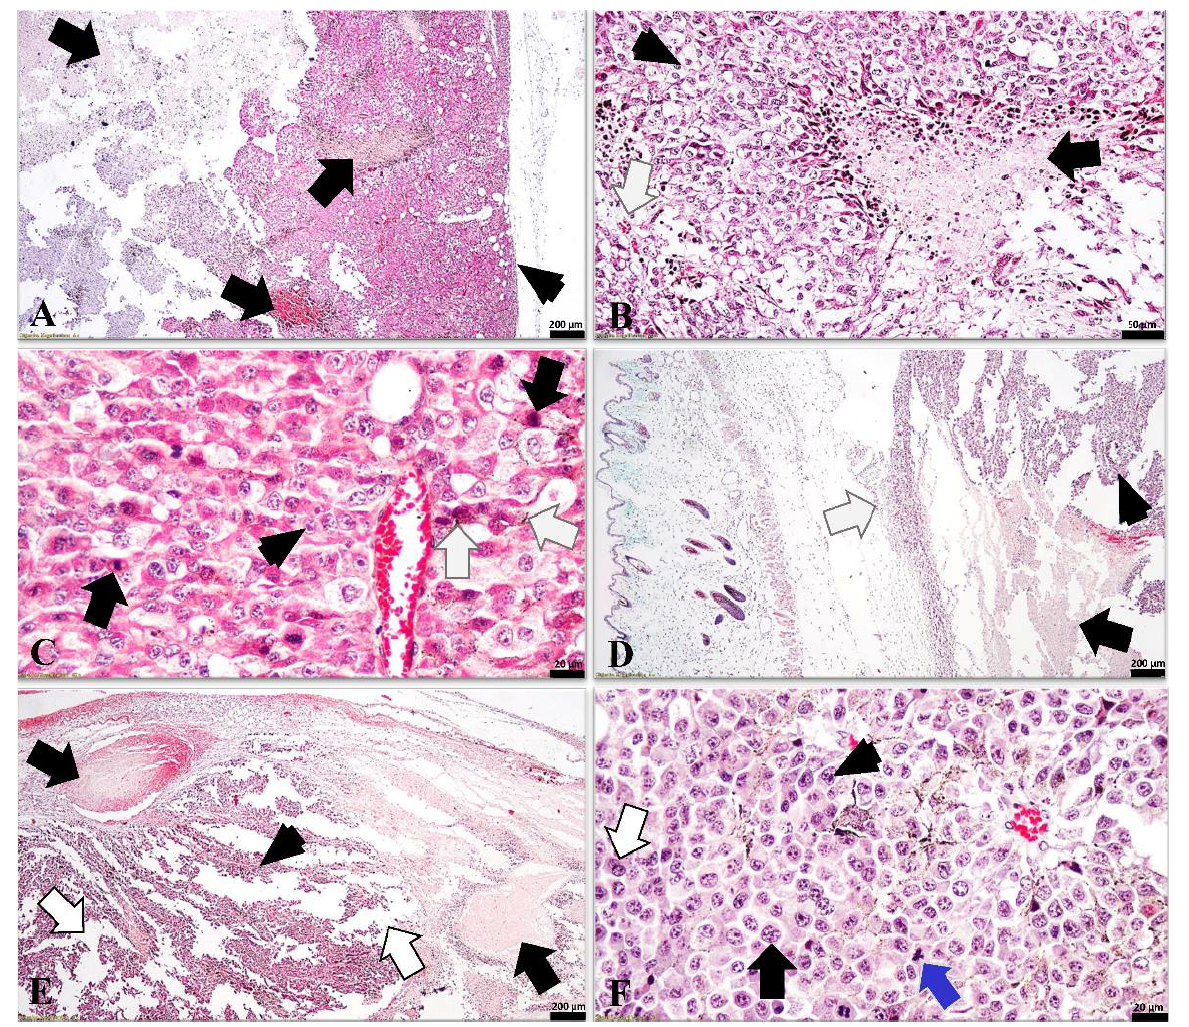
Figure 10. Cutaneous anaplastic melanoma in mice (Goldner’s trichrome stain): ( A ) (control group— M1): large tumoral mass with extended necrotic areas (arrows) and a discreete capsule (arrowhead); ( B ) (control group—M8): microscopic features of the melanoma suggesting cellular debris of the necrotized areas (black arrow), tumoral parenchyma (arrowhead) that includes a discrete sustain- ing tissue (white arrow); ( C ) (control group—M3): highly cellularised melanoma, with tumoral melanocytes displaying anisocytosis, large nuclei and nucleoli (arrowhead), numerous mitotic figures (black arrows), and discreete melanic granules in the cytoplasm of some tumoral cells (white arrows); ( D ) (group melanoma + rhodoxanthin—MR1): the location of the tumoral mass in the hypoder- mis (arrowhead), which presents large necrotic areas (black arrow) and an ill-defined infiltrated capsule (white arrow); ( E ) (group melanoma + rhodoxanthin—MR1): thrombi in the tumoral mass (arrows), a discrete sustaining tissue identified in between the parenchyma cells (arrowhead) and a low intercellular adhesion suggested by large intercellular spaces (white arrows) suggesting rapid growth and high malignancy; ( F ) (group melanoma + rhodoxanthin—MR8): poorly differentianted melanoma suggested by high cellular pleiomorphism, large nuclei (black arrow) including binu- cleated melanocytes (white arrow), in many circumstances with macronucleoli (arrowhead), high mitotic index that includes atypic mitoses (blue